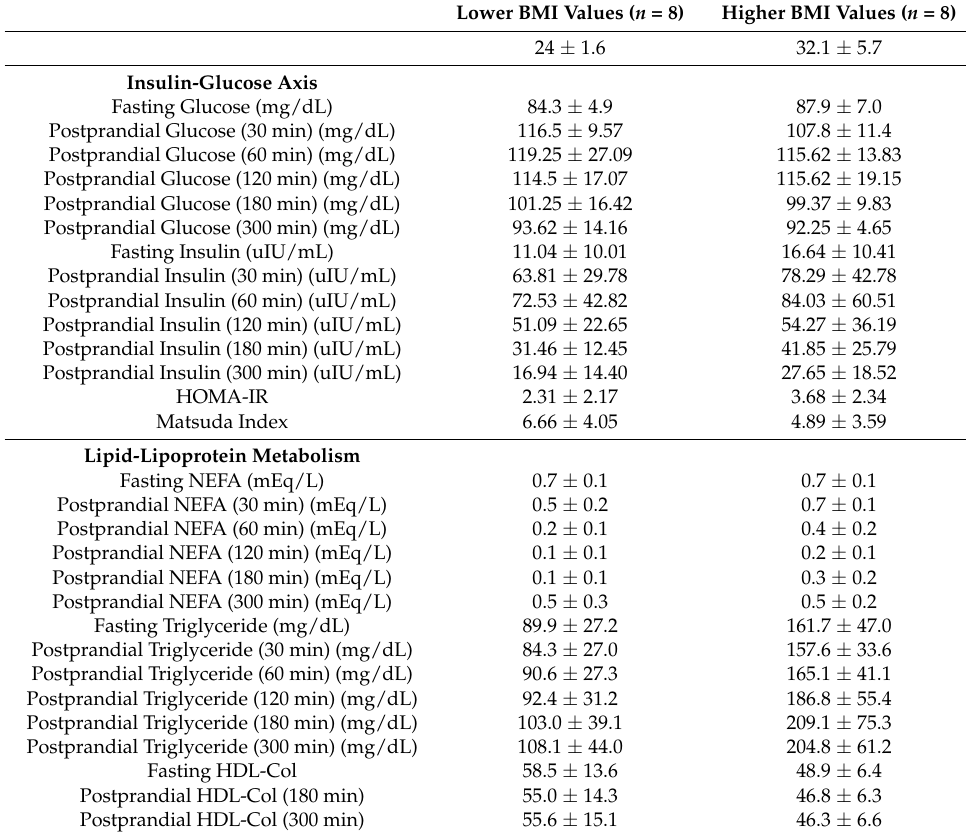
Table 2. Fasting and postprandial phenotypes related to the insulin-glucose axis, lipid-lipoprotein metabolism and insulin-mediated glucose disposal.